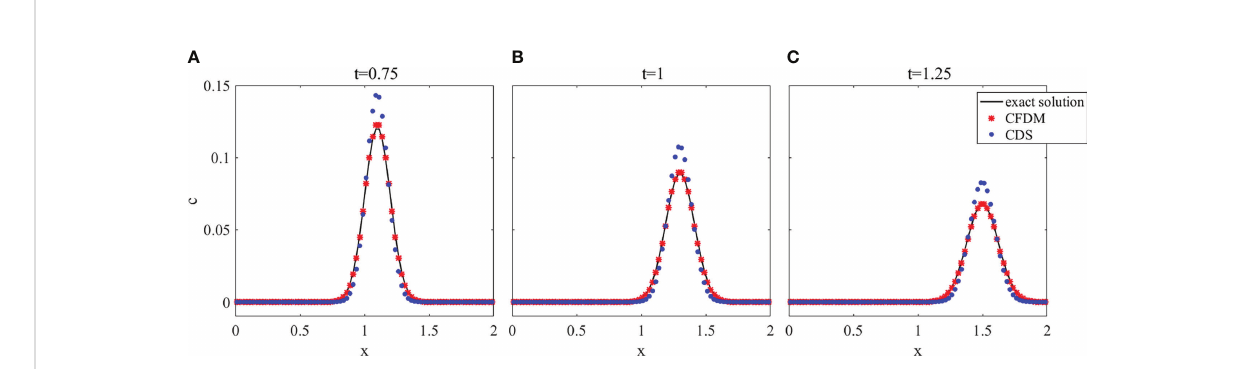
FIGURE 2 The surface plots in the section of y = x of the 3D Gaussian hump at z = 0.6 with different times. (A) t=0.75, (B) t=1, (C)